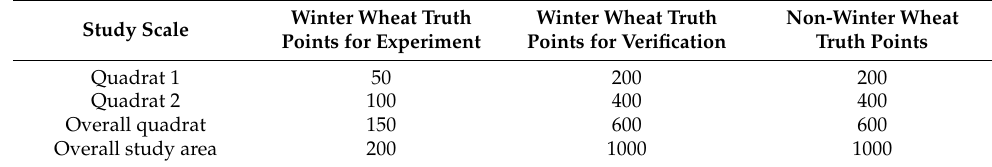
Table 2. The number of truth points selected on different